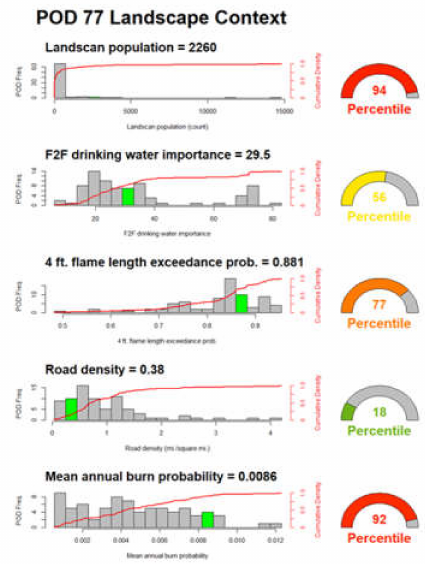
Figure 5. First page of POD Atlas showing focal POD boundaries in relation to aerial imagery, road layers, adjacent PODs, and strategic response categories, and describing land ownership in the POD.